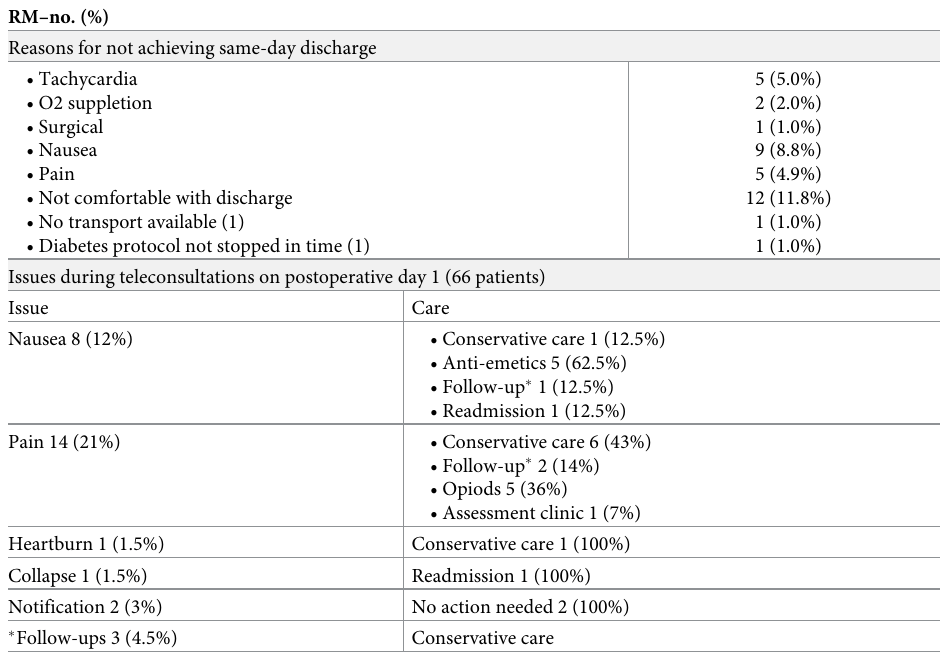
Table 4. Reasons for not achieving same-day discharge versus issues during teleconsultation.